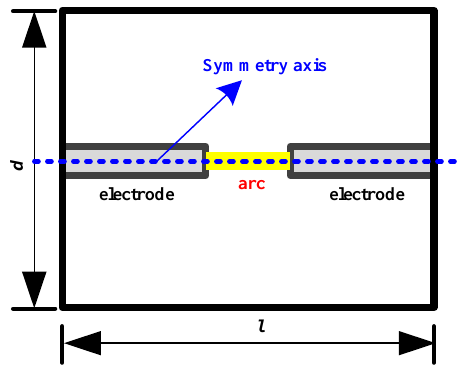
Figure 5. Cross-section of the simulation model.